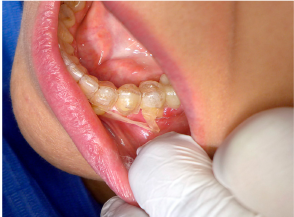
Figure 8. A force of the elastics gives a moment to the tooth (premolar 35) where the 3D printed biocompatible power-arm is attached (variant I. year